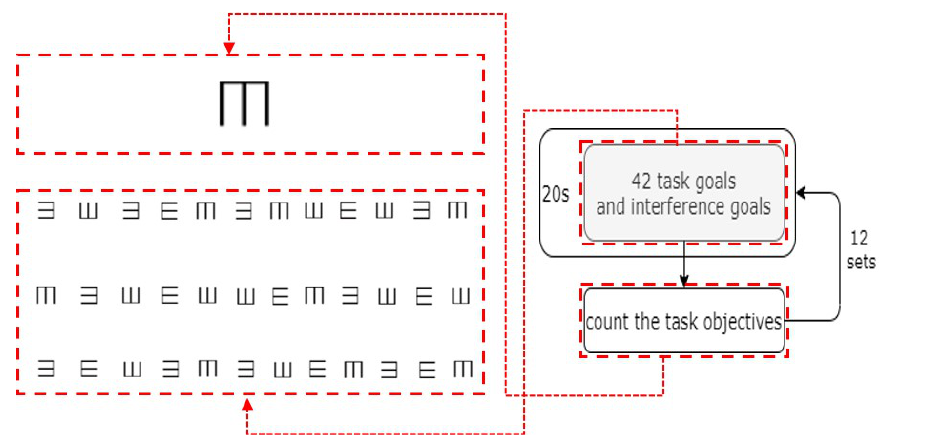
Figure 3. Contents of E-word memory test.